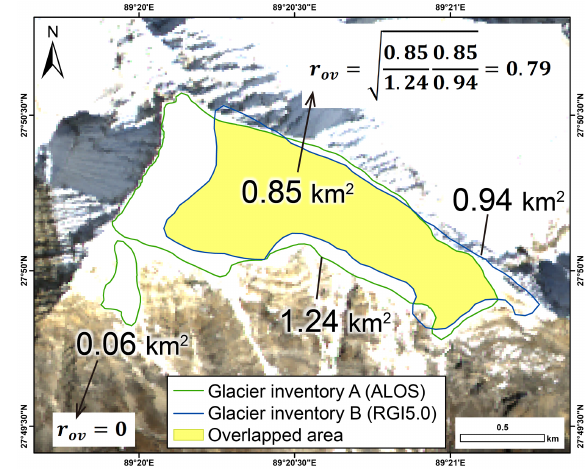
Figure 6. Conceptual example of the overlap ratio ( r ov ). The back- ground is an ALOS AVNIR-2